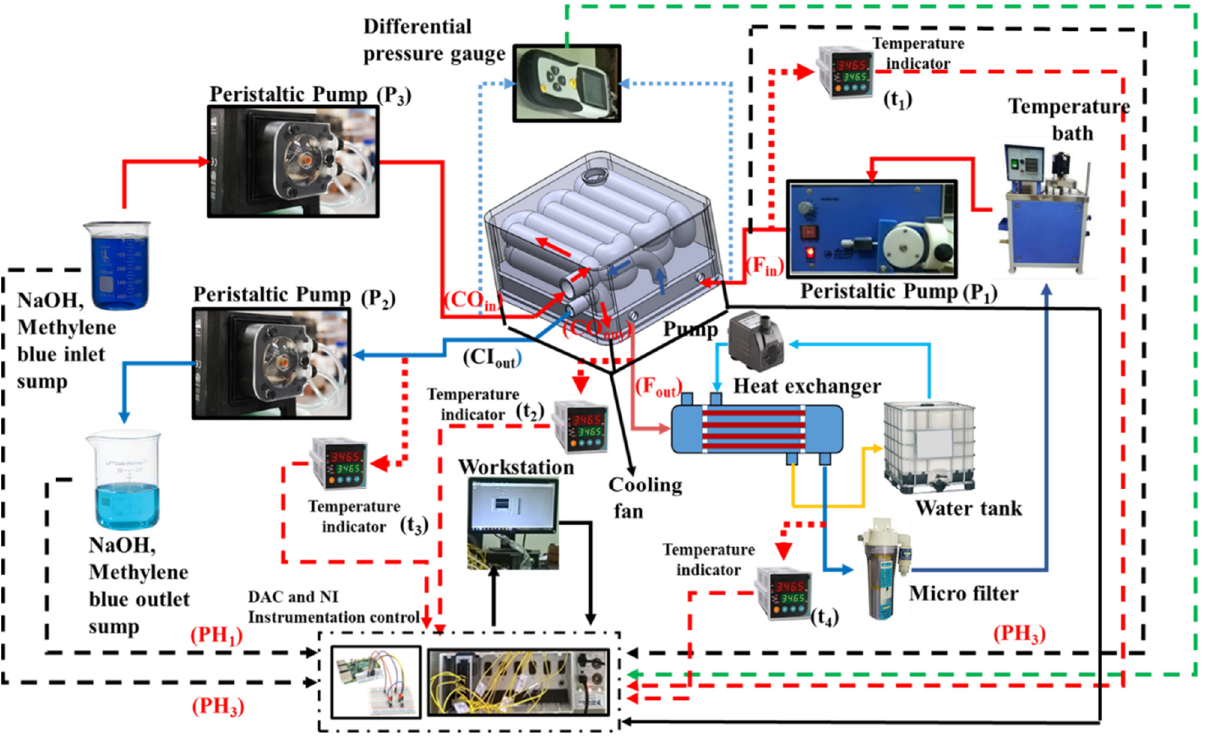
Figure 6. Schematics of the experimental fl ow line with respective components and sensor used.